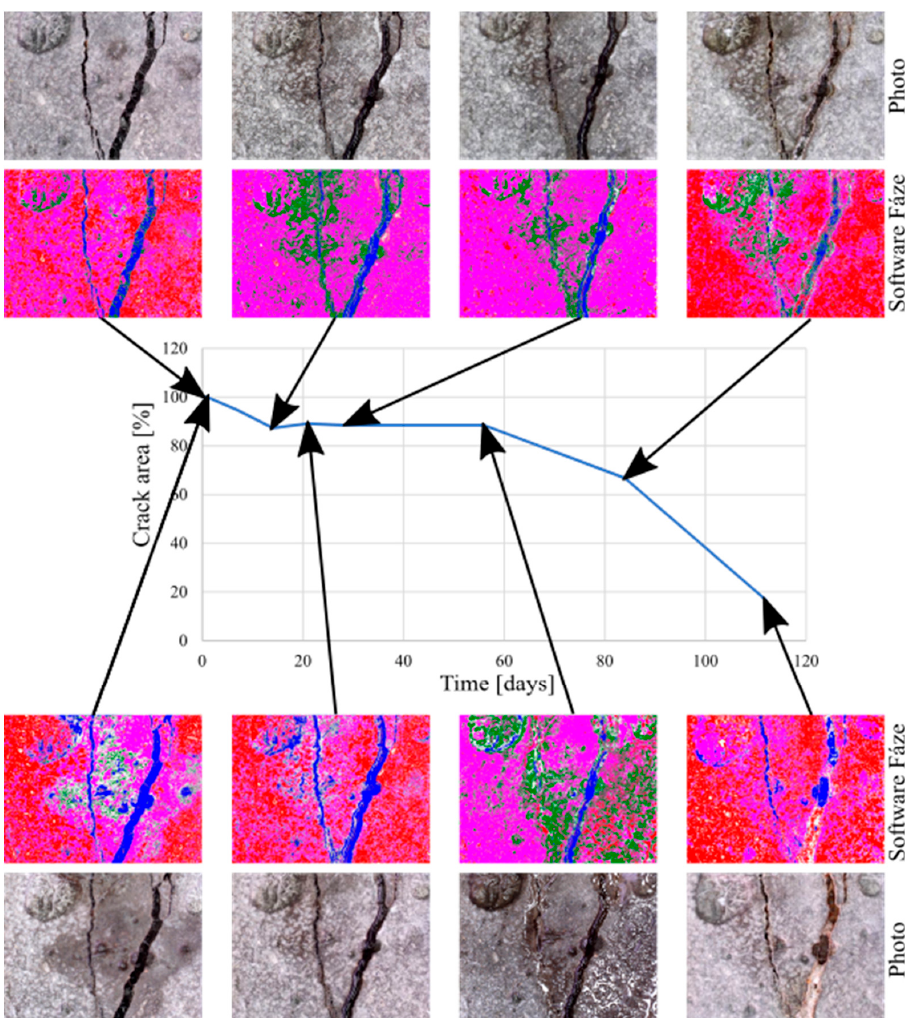
Figure 12. Microscope analysis and evaluation through Fáze software—graph creation. Materials 2020 , 13 , x FOR PEER REVIEW 14 of 18